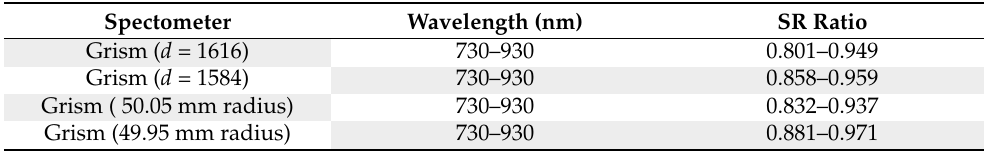
Table 2. Strehl ratio for precisions in practical fabrications of optical